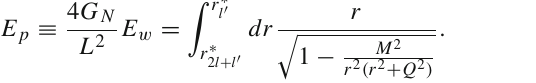
(negative) for the set of parameters in one branch the system is thermodynamically stable (unstable). The two branches intersect at the critical point where (